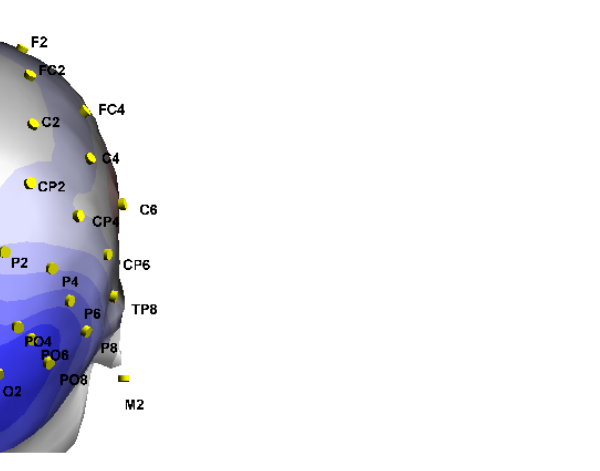
Figure A2. Depiction of the FMT pre (baseline) and post grand-average ERP waveforms for those in the Control group. This illustrates the scalp activity within all electrodes from a latency period of—10 ms to 200 ms after median nerve stimulation.